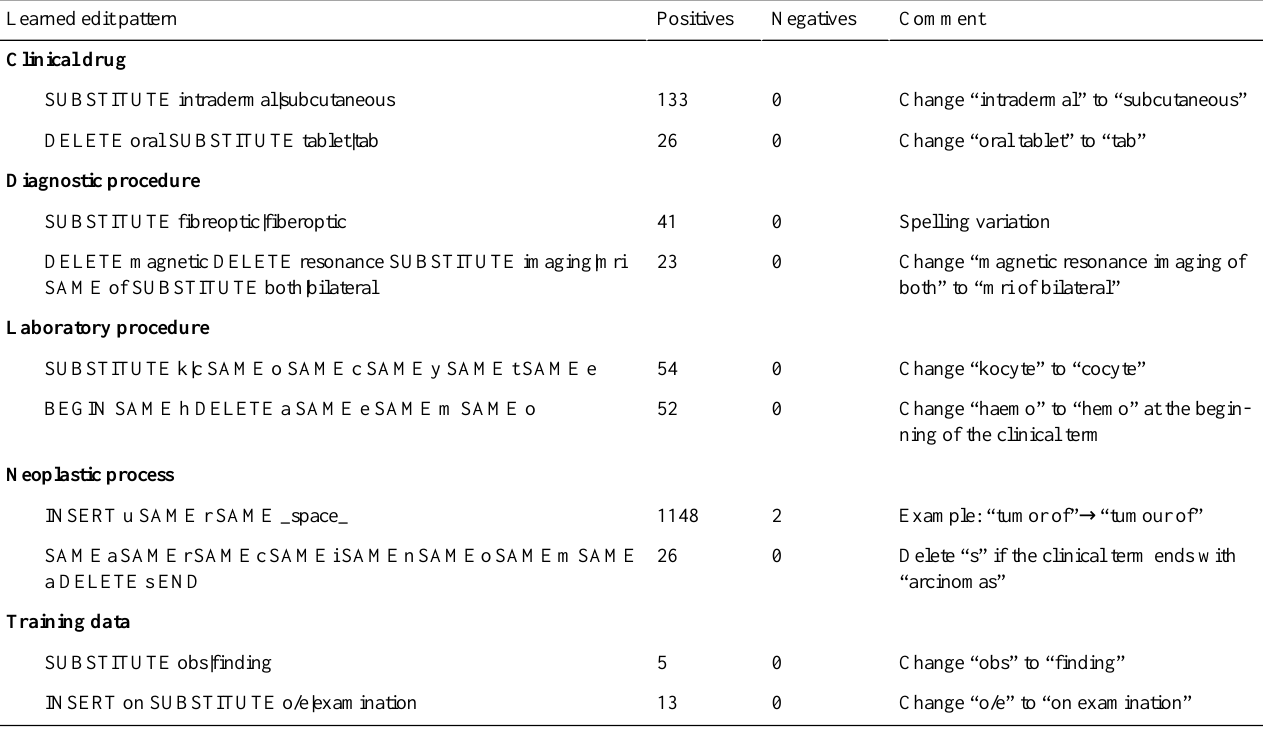
Table 1. Illustrative examples of edit patterns automatically learned from UMLS for a few semantic types and automatically learned from the training data. The first 4 and the last 2 edit patterns are word-based, whereas the remaining 4 edit patterns are character-based. The number of positives and negatives of each pattern are also